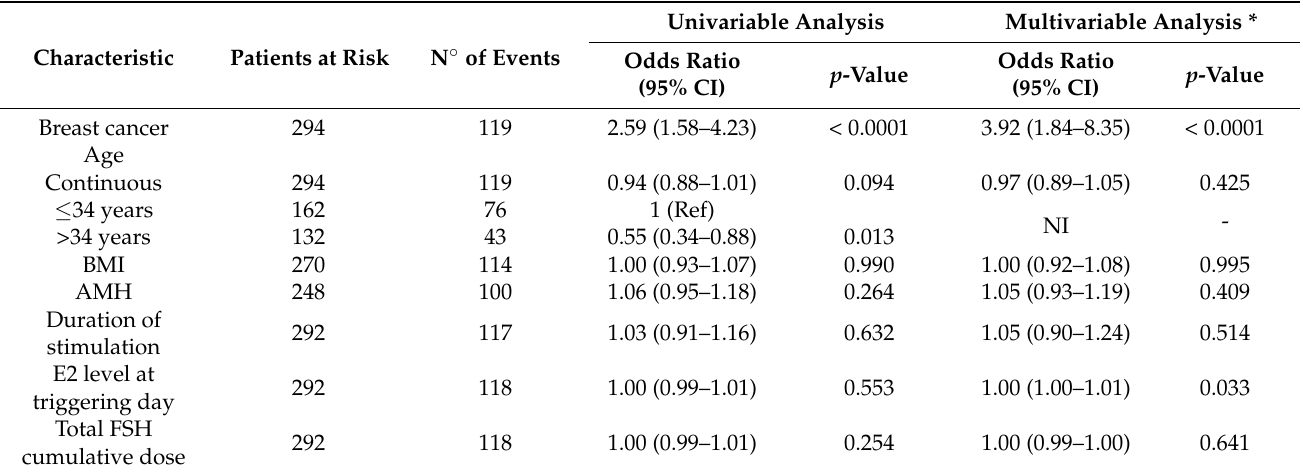
Figure 2. Comparison between a denuded MII oocyte ( A ) and a dysmorphic oocyte ( B ). 400× magnification. A : Intact polar body in the perivitelline space (red arrow) and normal homogeneous cytoplasm. B: Fragmented polar body (red arrow) and enlarged perivitelline space with granules (blue arrows); granular cytoplasm. Table 4. Impacts of variables on the oocyte quality: uni- and multivariable logistic regression according to the presence of dysmorphic oocytes.